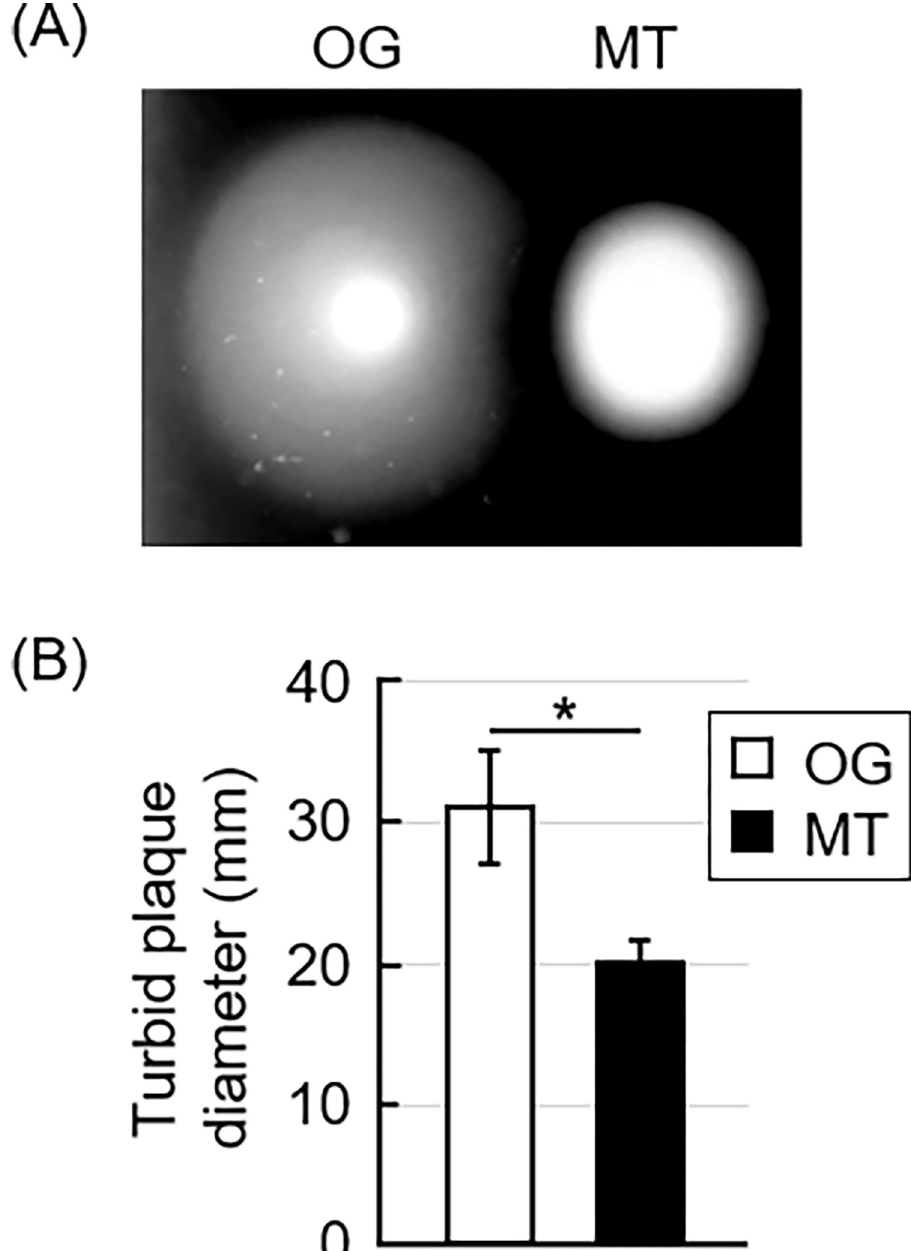
Fig 2. Motility assay. The original (OG) and mutant (MT) strains were inoculated on the surface of the medium containing 0.5% agar and incubated for five days at 37˚C under the anaerobic conditions. A typical result is shown in panel A. This experiment was performed three times in different cultures, each in quadruplicate, and the mean and SD are shown in panel B. � Statistically significant difference between the strains ( P < 0.01). in 10 and 37 genes, respectively, compared to that in OG (Table 4). Among the 10 genes with higher transcriptional activity in MT, seven genes were annotated with a transporter. In con- trast, 10 genes with similar annotations were also detected in the genes with lower transcrip- tional activity in MT. The TDE_1072 gene showed the highest fold change value, and an